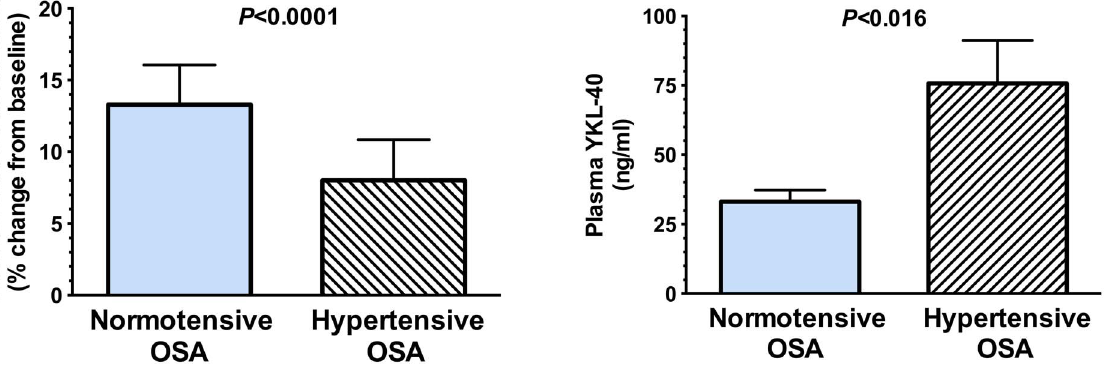
Figure 1. Endothelial-dependent nitric oxide-mediated vasodilatory capacity and Plasma YKL-40. Hypertensive OSA patients had marked impairment in flow-mediated vasodilation compared with normotensive OSA. Plasma levels of YKL-40 in hypertensive OSA were significantly higher than the normotensive OSA subjects. doi:10.1371/journal.pone.0098629.g001 PLOS ONE |